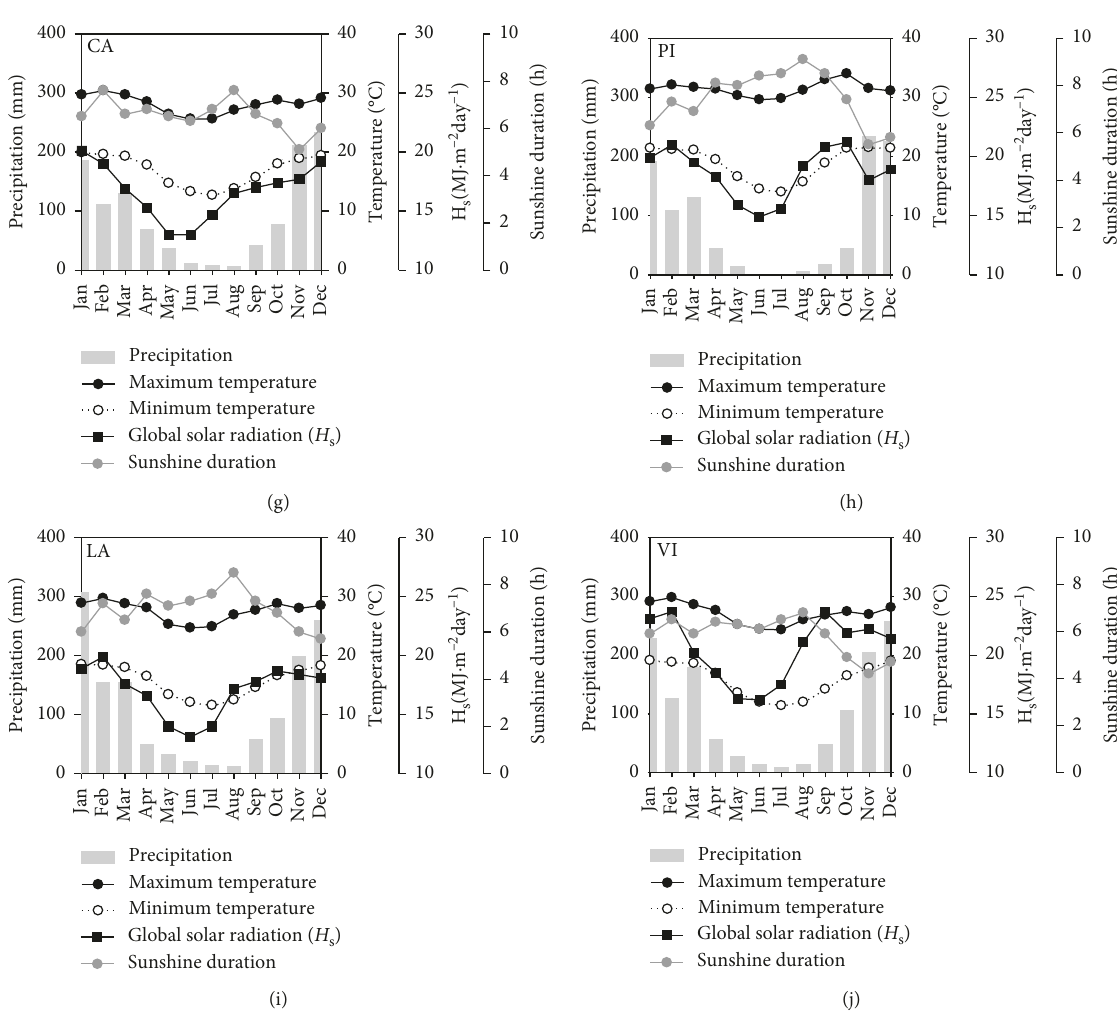
Figure 2: Monthly variation of global solar radiation ( H · m − 2 day − 1 )), maximum air temperature ( T m´ax ( ° C)), minimum air temperature s (MJ ( T m´ın ( ° C)), sunshine duration ( n (hours)), and average accumulated precipitation ( P (mm)) from ten locations in Minas Gerais. AC � Araçua´ı; AR � Arax´a; BH � Belo Horizonte; CA � Caratinga; LA � Lavras; MA � Machado; MC � Montes Claros; PA � Paracatu; PI � Pirapora; VI �